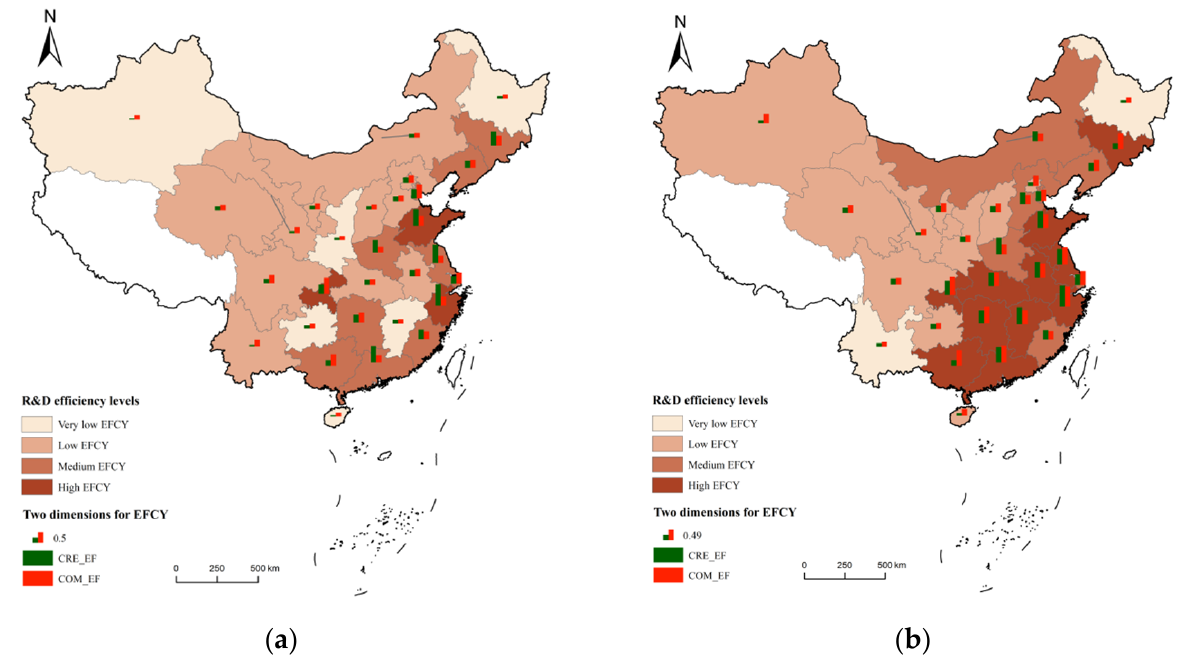
Figure 2. Spatial distributions of R&D productivity in ( a ) 2009 and ( b ) 2017 in China. KNOW_PY and TECH_PY are knowledge productivity and technology transfer productivity, respectively.